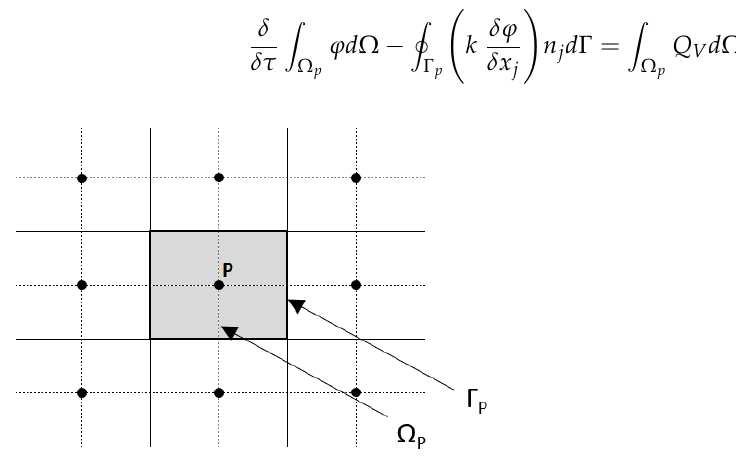
Figure 1. Exemplary scheme of Control Volume geometry discretization.